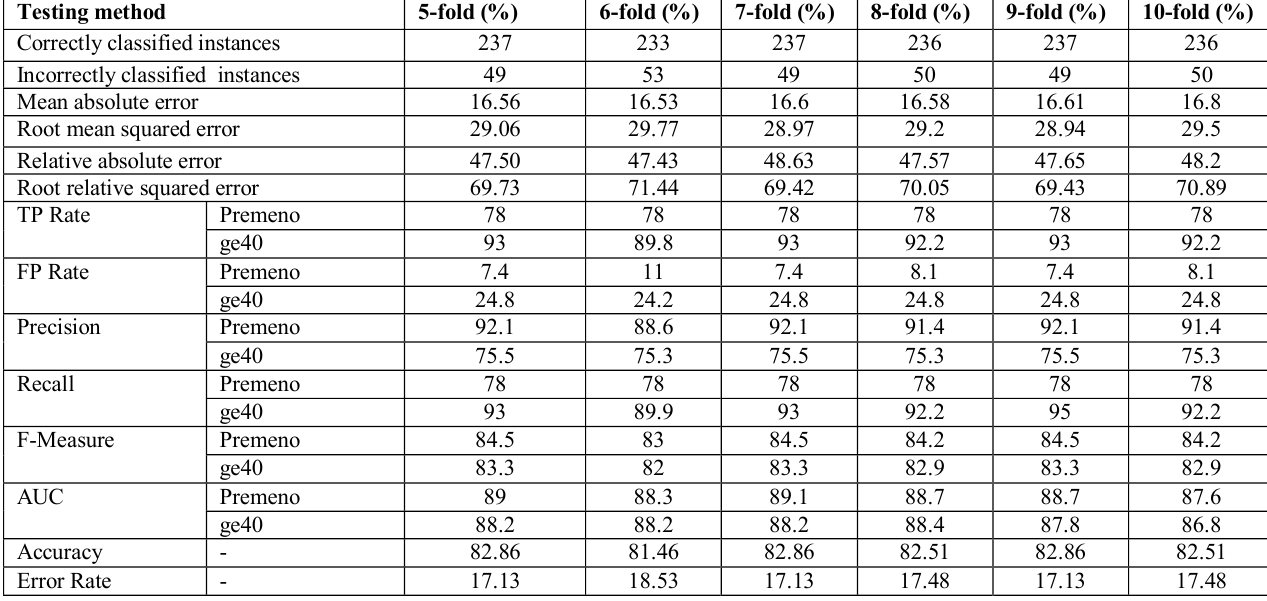
Table 3. Performance metrics of C4.5 using method